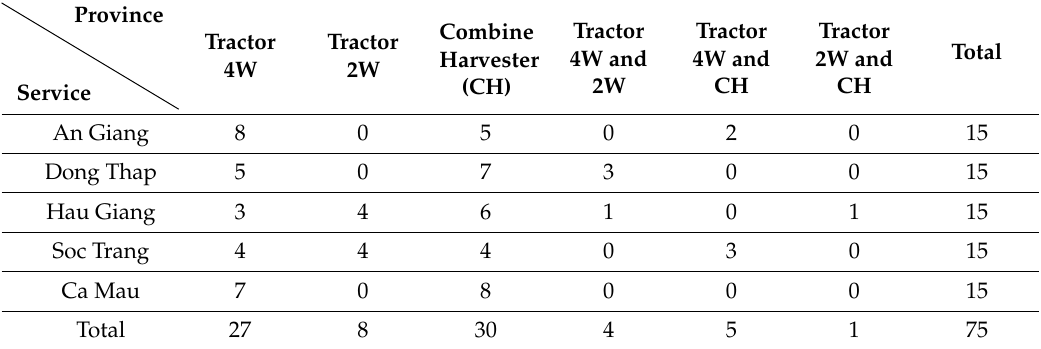
Table 2. Number of farm machinery service providers surveyed by province and service type.